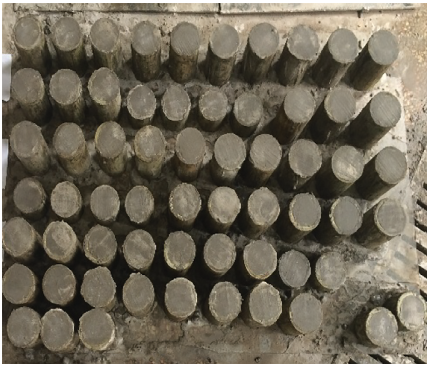
Figure 1: Part of the molded